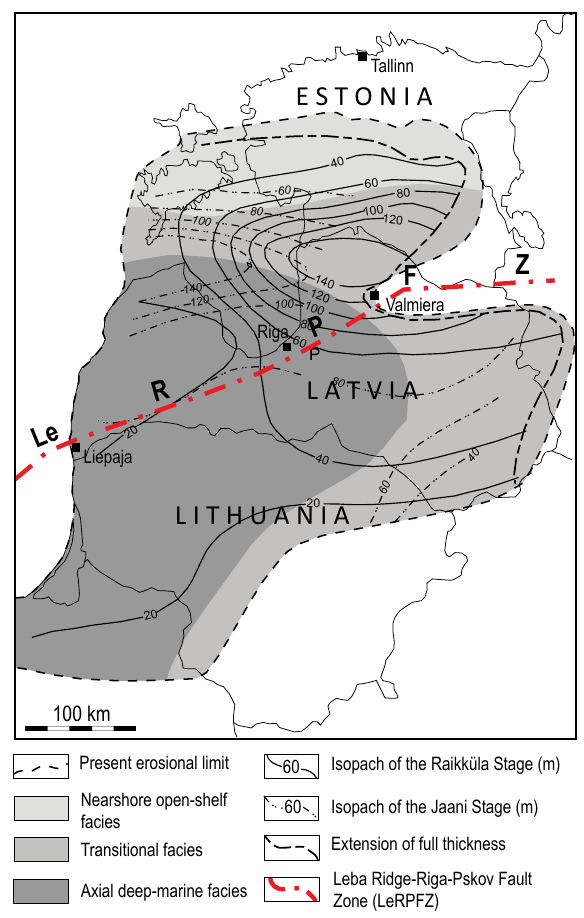
Fig. 5. The facies distribution of the Baltic Basin with the Livonian Tongue around the LeRPFZ during late Hirnantian (Porkuni) time (modified after Nestor & Einasto 1997).